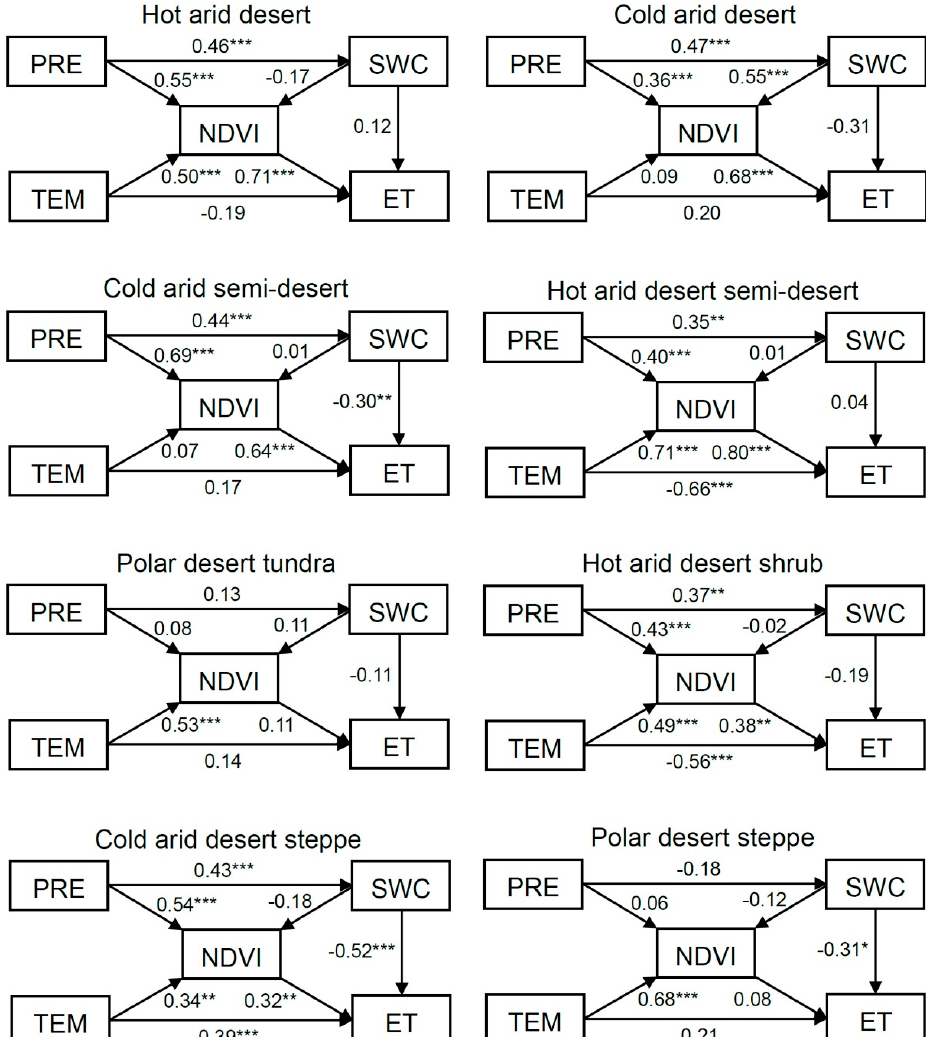
Figure 5. Structural equation model of the mean annual NDVI and climatic factors in di ff erent desert areas over the Silk Road Economic Belt between 1982 and 2015. *, **, and *** indicate statistical significance at p < 0.1, p < 0.05, and p < 0.01, respectively. PRE —Precipitation, SWC —Soil water